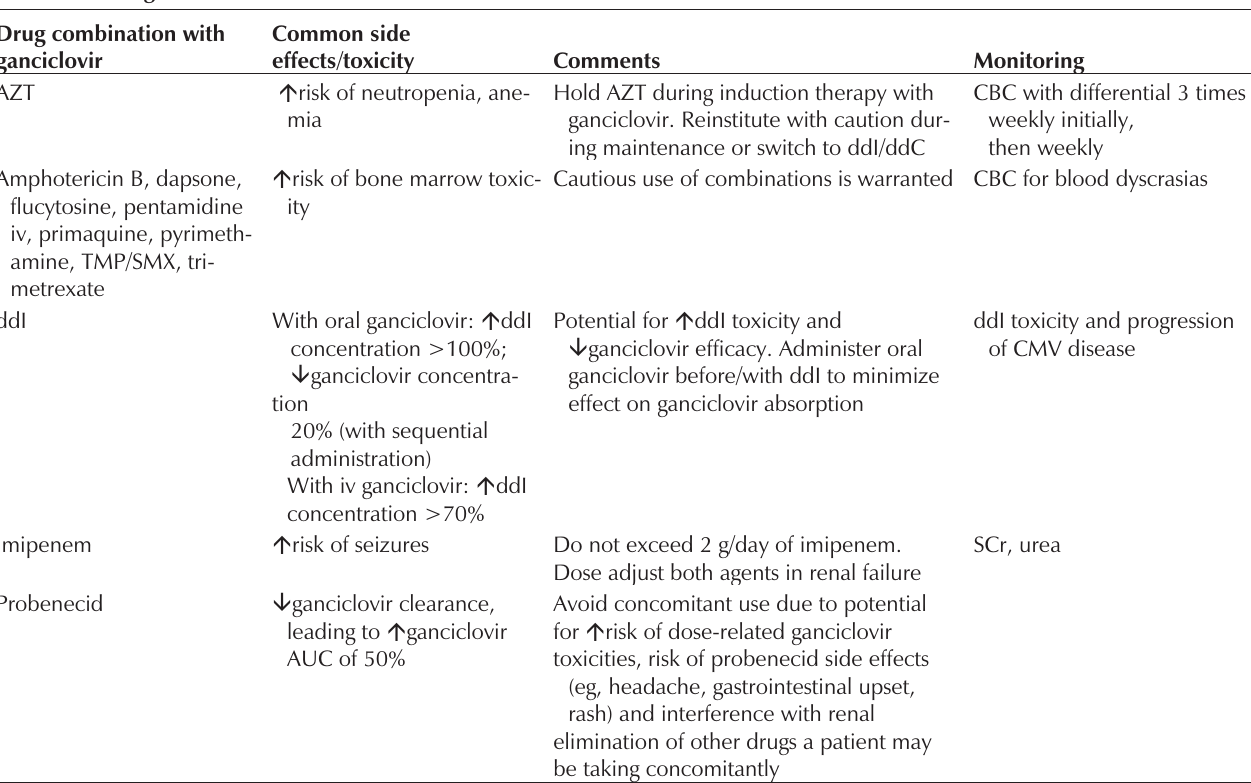
Ganciclovir drug